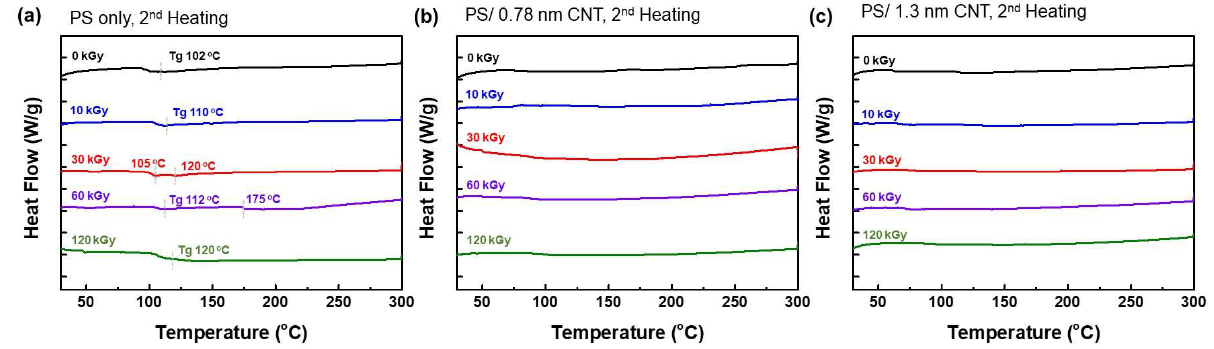
Figure 3. The effect of gamma irradiation on the DSC thermograms (second heating) of PS ( a ), PS/SW-CNT composites with a diameter of 0.78 nm ( b ) and 1.3 nm ( c ), at different integral doses.